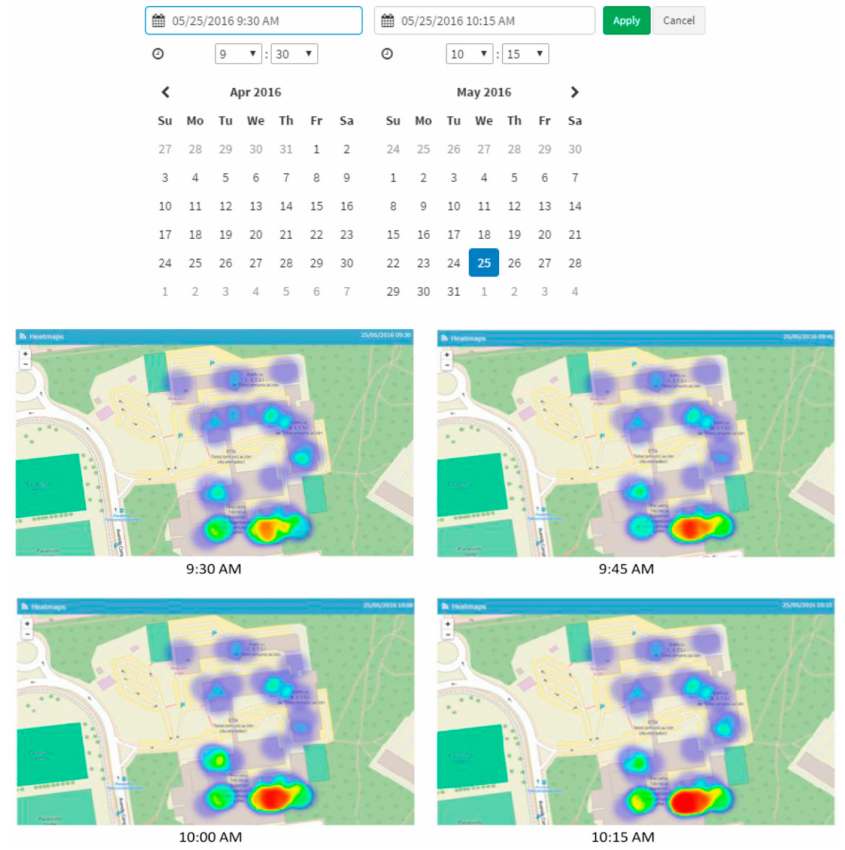
Figure 14. Historical occupation data for the Telecommunications Engineering School. It allows selecting the day and the time